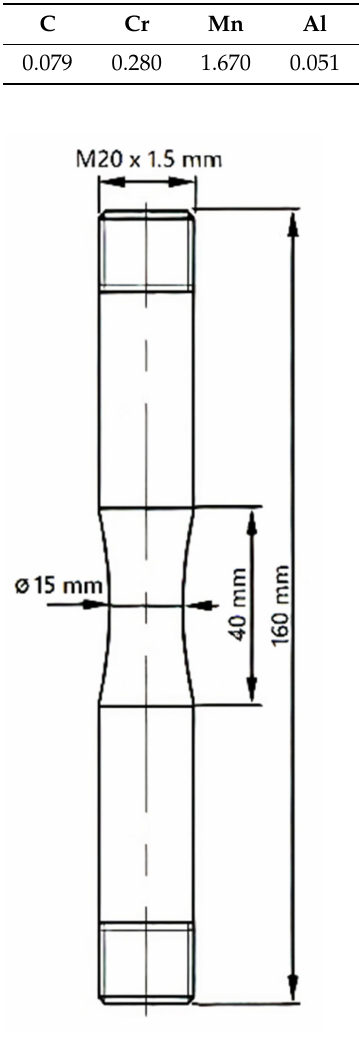
Figure 1. Sample geometry in